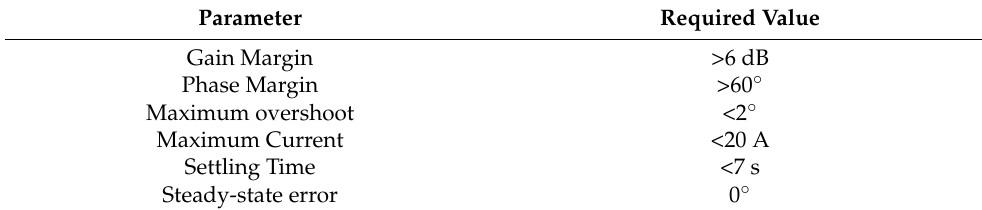
Table 2. Control requirements for designing the controller for the switch system.